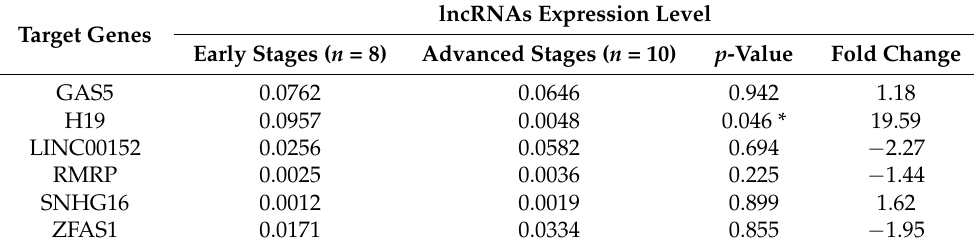
Table 4. The fold change for lncRNAs GAS5, H19, LINC00152, RMRP, SNHG16, and ZFAS1 expres- sion level in exosomes of early-stages (stage I & II) and advanced stages (stage III & IV) of CRC